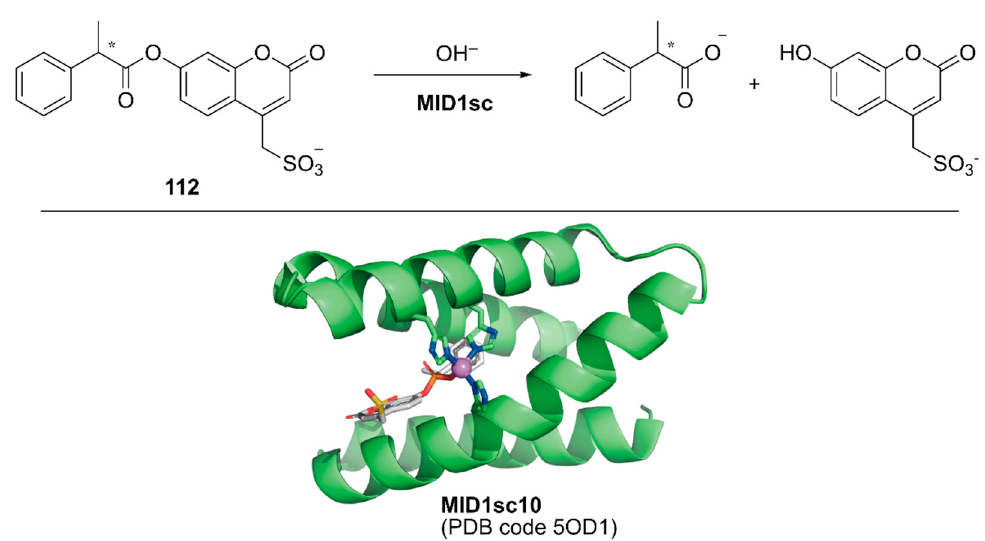
Figure 22. Hydrolysis reaction catalyzed by MID1sc and the crystal structure of MIDsc10 (PDB code: 5OD1). Adapted from [124]. The peptide scaffold is depicted as a green cartoon. Carbon, nitrogen, oxygen, phosphorus, and sulfur atoms are shown in green, blue, red, orange, and yellow, respectively. The Zn ion is shown as a purple sphere. A phosphonate transition state analog is shown as a gray stick structure.